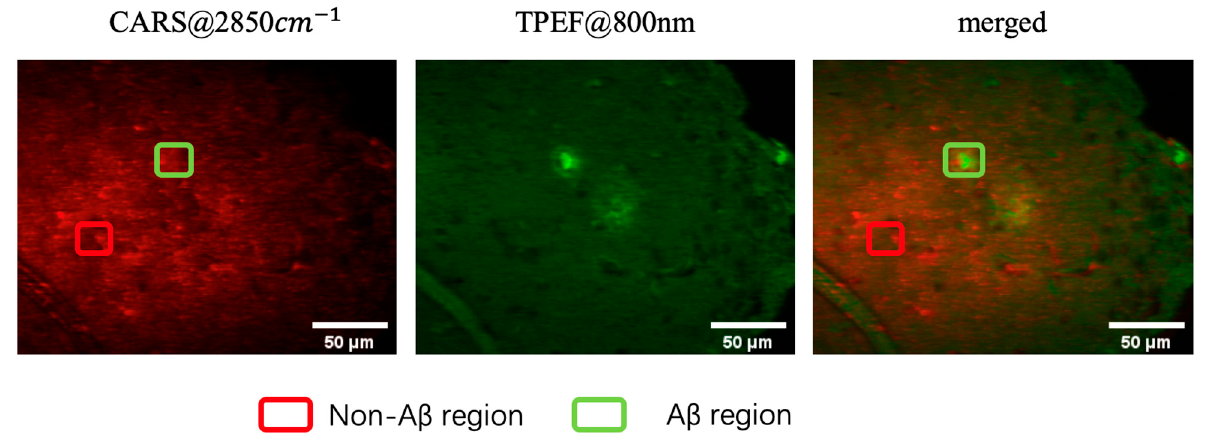
Figure 2. CARS and TPEF images of brain tissue from a mouse model of AD: ( Left ) CARS image acquired at 2850 cm –1 ; ( middle ) TPEF image excited at 800 nm; ( right ) merged image. The red and green boxes represent the non-A β and A β regions, as indicated by the TPEF image shown in the middle panel. Scale bar, 50 µm.